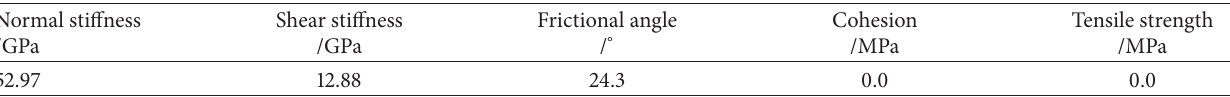
Figure 4: Evolution characteristics of the successive yielding in CRDM. Table 1: Mechanical parameters of joints.